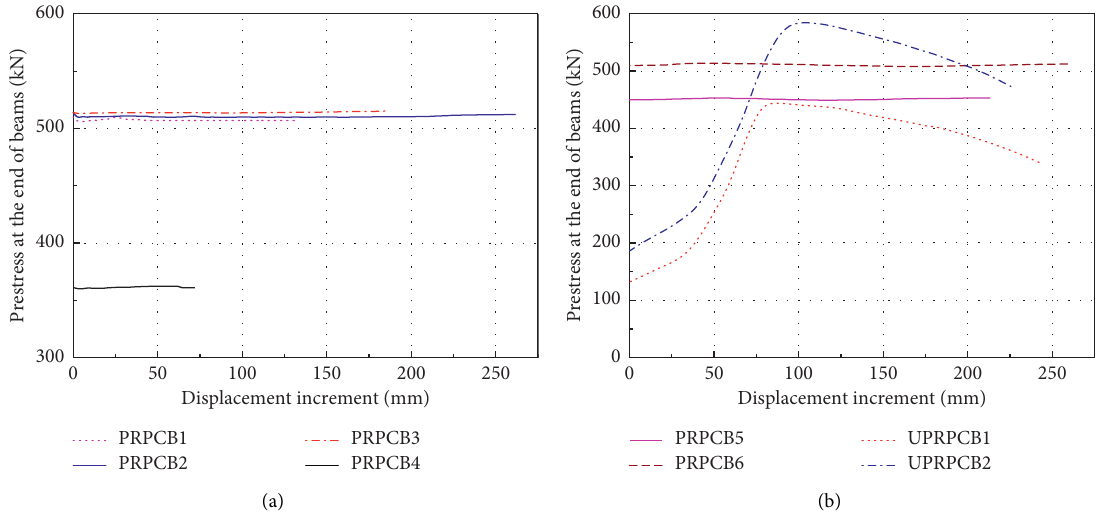
Figure 11: Changes of prestress of tendons with displacement increment. (a) The first batch test. (b) The second batch test.